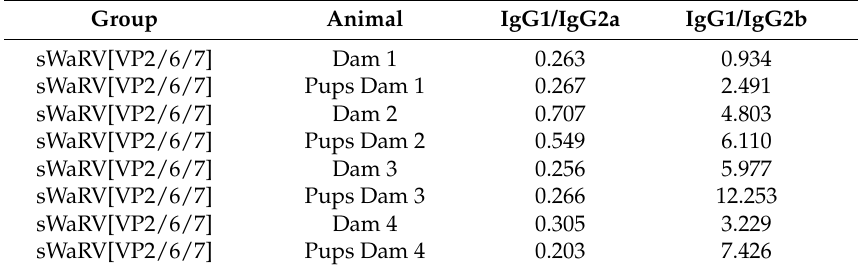
Table A5. Ratio of IgG isotype values from sWaRV[VP2/6/7] immunized animals from Table A10.